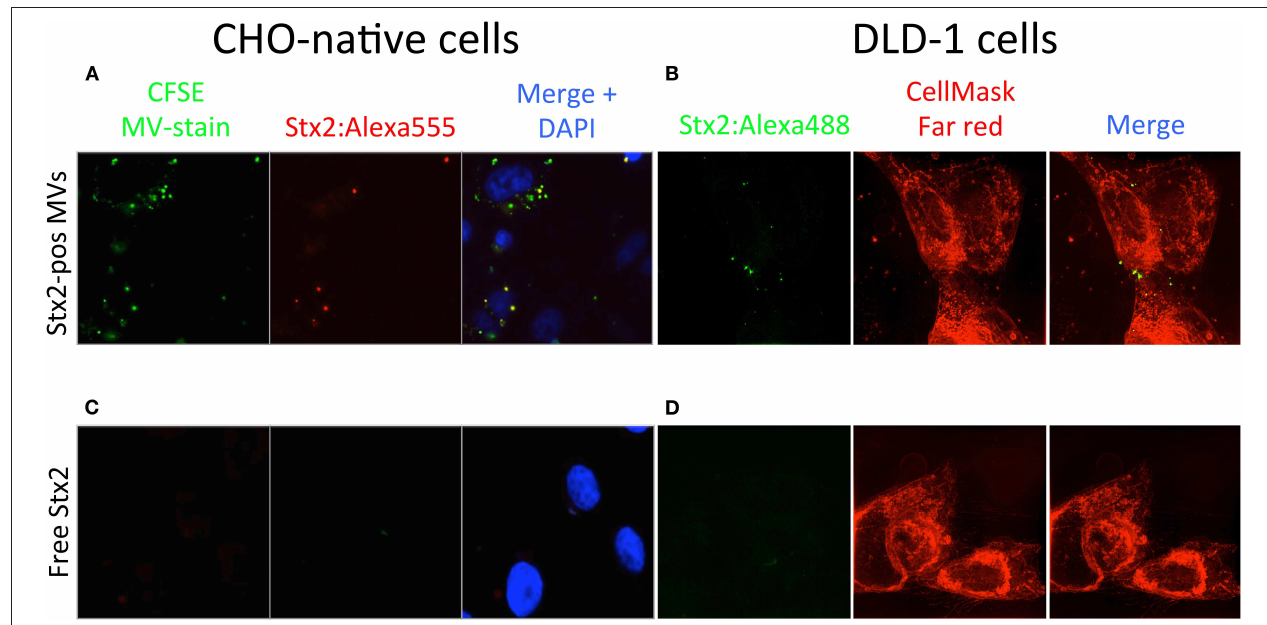
FIGURE 4 | Shiga toxin 2 can be taken up by Gb3-negative cells within microvesicles. (A) CHO-native cells were incubated with CFSE-stained microvesicles (green dye) containing Stx2:Alexa555 (Stx2-pos MVs, red dye) and stained with DAPI. Fluorescence microscopy showed that microvesicles were associated with CHO-native cells and that some of the microvesicles were positive for Stx2:Alexa555. (B) DLD-1 cells were incubated with microvesicles positive for Stx2:Alexa488 (Stx2-pos MVs, green dye). 3D-SIM imaging showed that fluorescence corresponding with Stx2:Alexa488 was present within DLD-1 cells (as determined by z-stack acquisition) when delivered via microvesicles. (C) CHO-native cells were incubated with free Stx2:Alexa555 and stained with DAPI. No fluorescence was seen in CHO-native cells that had been given Stx2:Alexa555 in free form. (D) DLD-1 cells were incubated with free Stx2:Alexa488. No fluorescence was seen in DLD-1 cells that had been given Stx2:Alexa488 in free form. Two independent experiments were performed and representative results are presented.